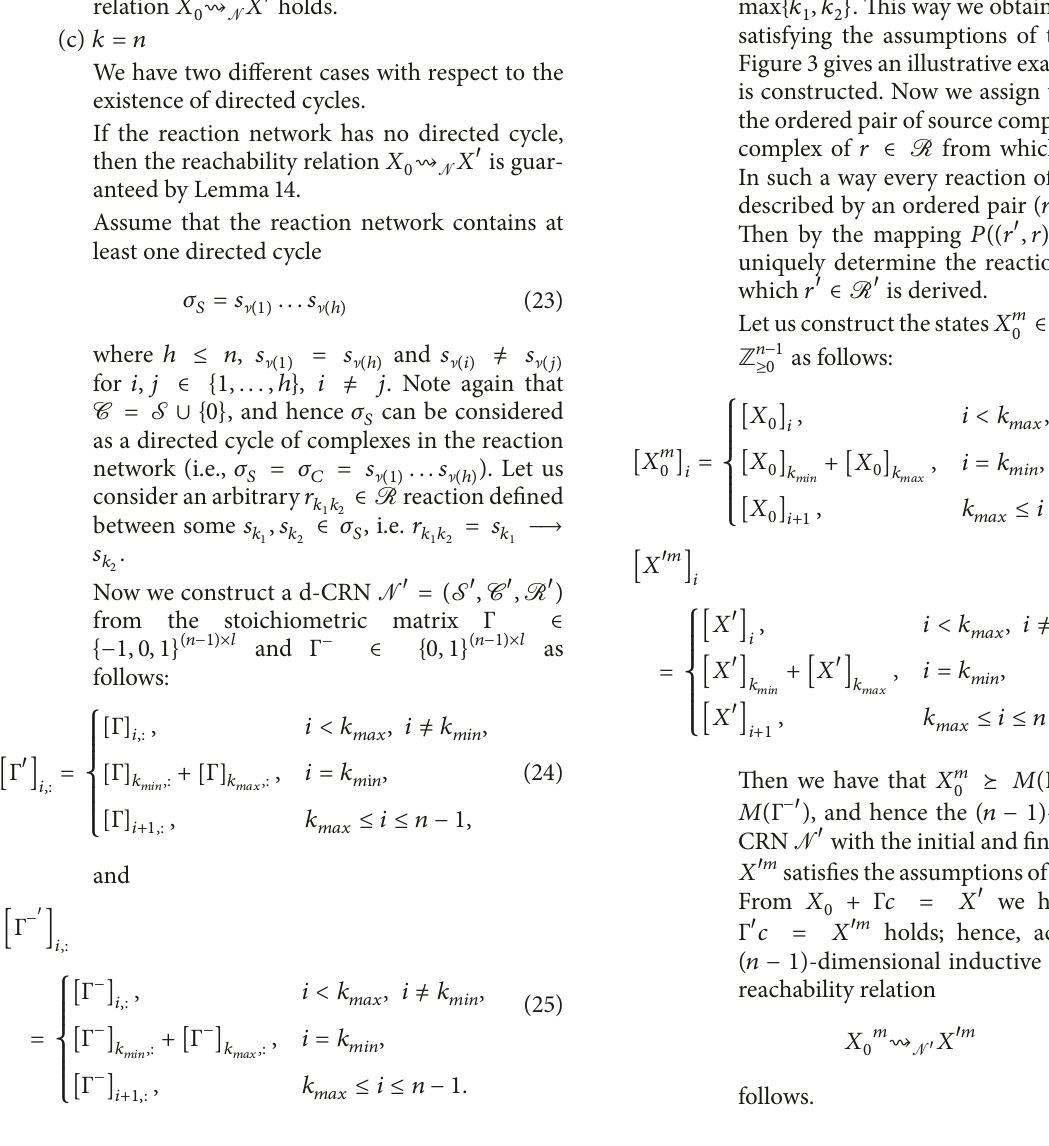
and 𝑠 𝑘 of N 1 2 𝑘 1 ), but they